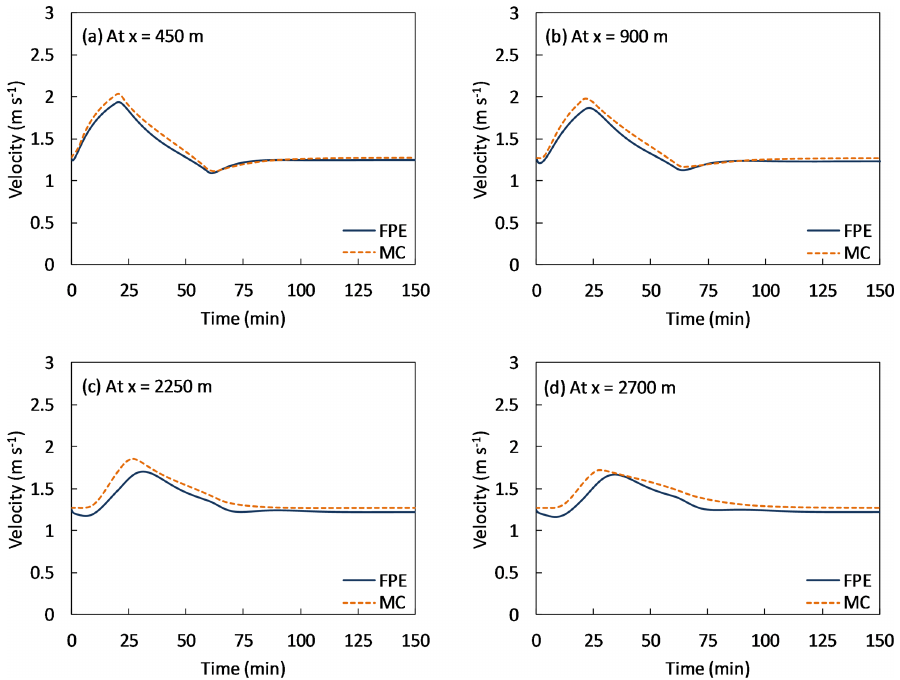
Figure 7. Comparison of the ensemble average velocity obtained by the FPE methodology and the MC approach as a function of time, at different channel